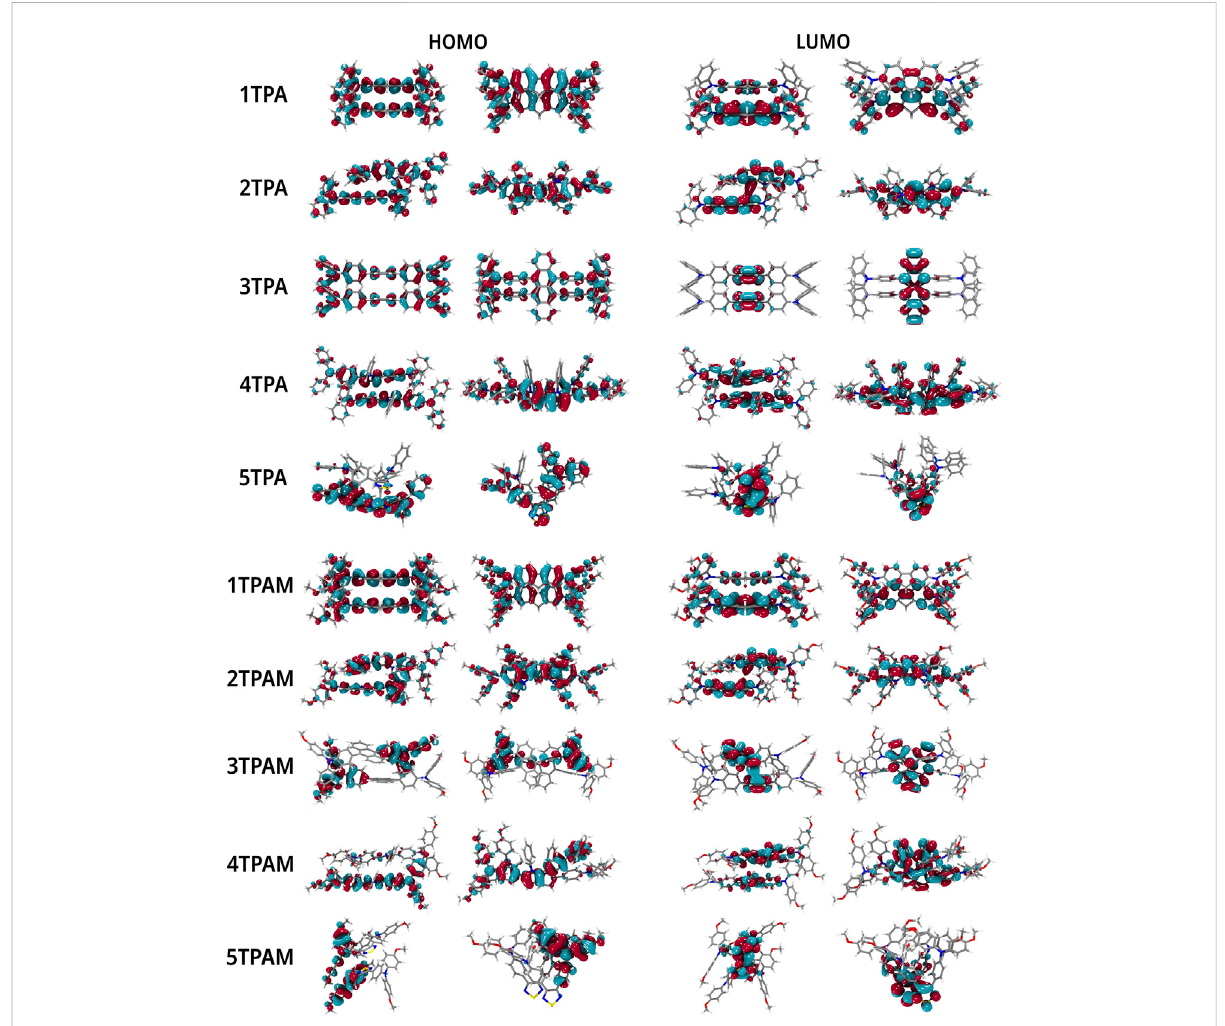
FIGURE 9 Localization of the frontier molecular orbitals in dimers of TPA and